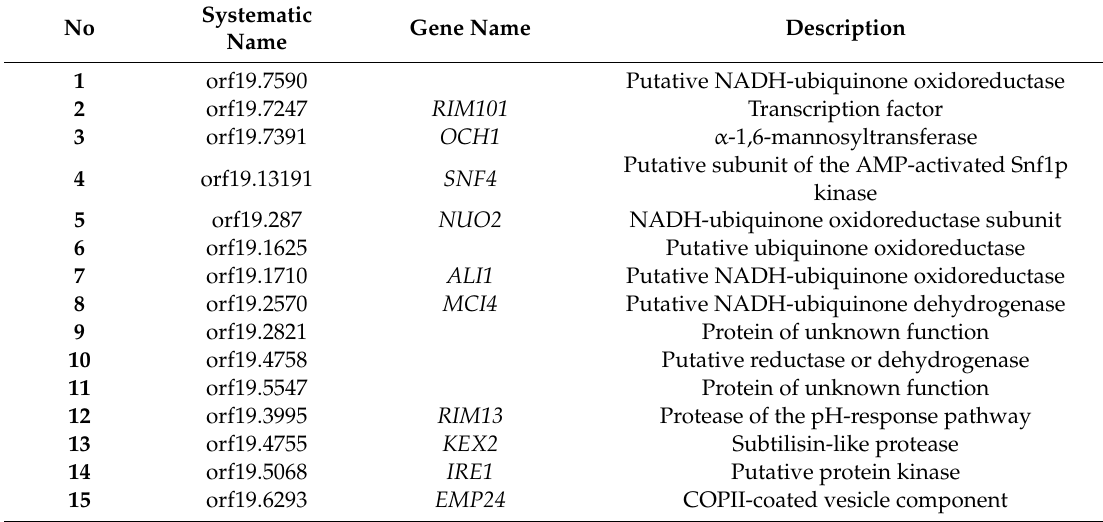
Table 1. C. albicans deletion mutants that were P-113